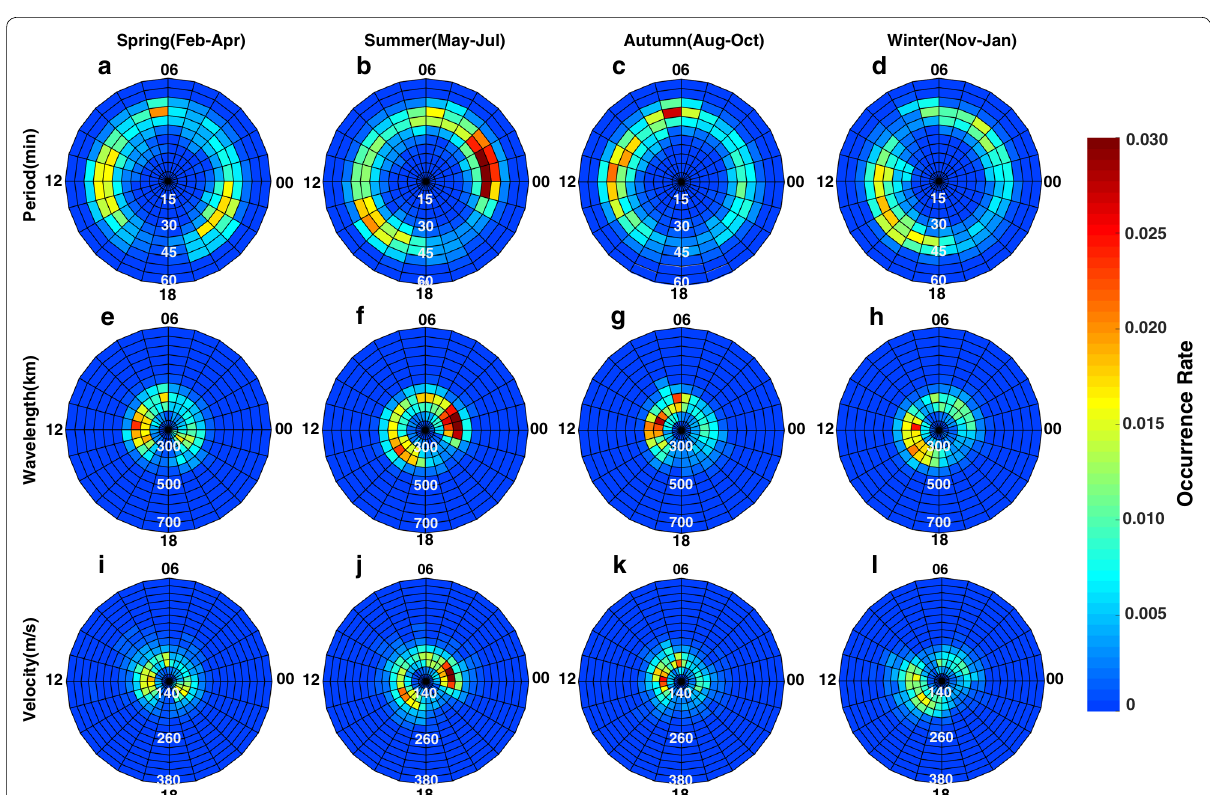
Fig. 4 LT variations in period, wavelength and velocity of MSTIDs for spring, summer, autumn and